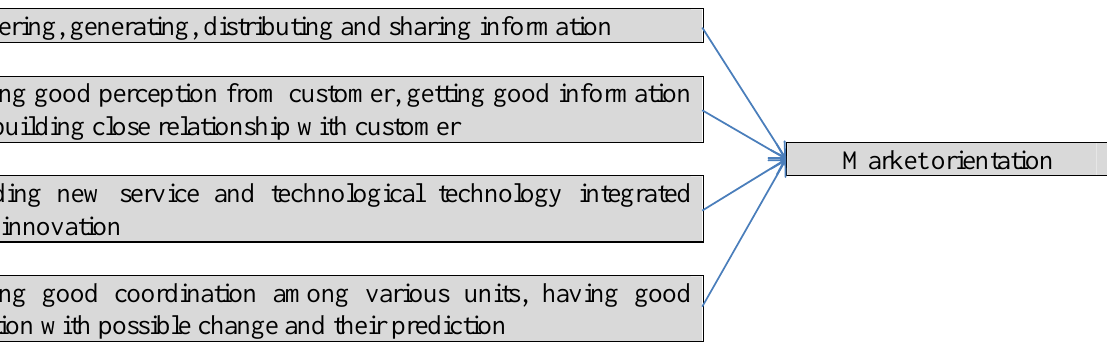
Fig. 1. The structure of the proposed